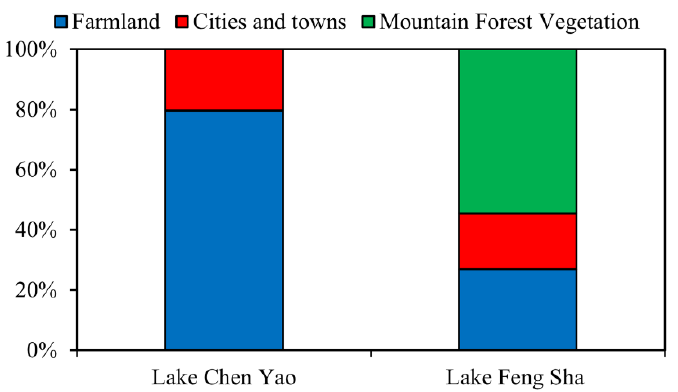
Figure 2. Distribution of land use types around Lake Chen Yao and Lake Feng Sha.